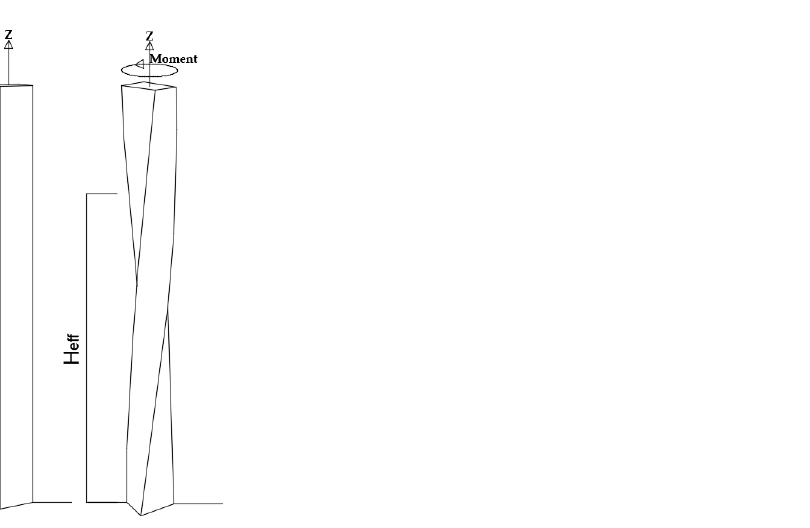
does not depend on the value of eccentricities.